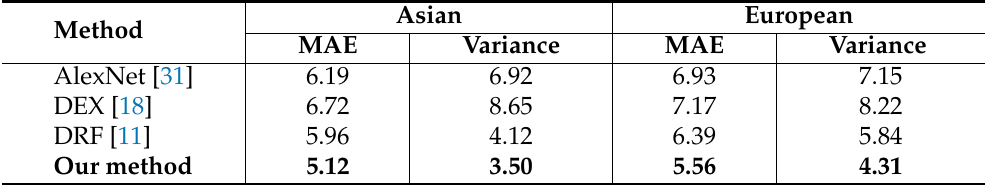
Figure 7. Examples from the facial video datasets with age and head pose estimates. The numbers represent the predicted age. Green and red colors indicate that the sum of the head pose rotational angles is less than and greater than 30 degrees, respectively. Table 4. Accuracy (MAE) and variance results for comparison with state-of-the-art methods on the Asian and European facial video